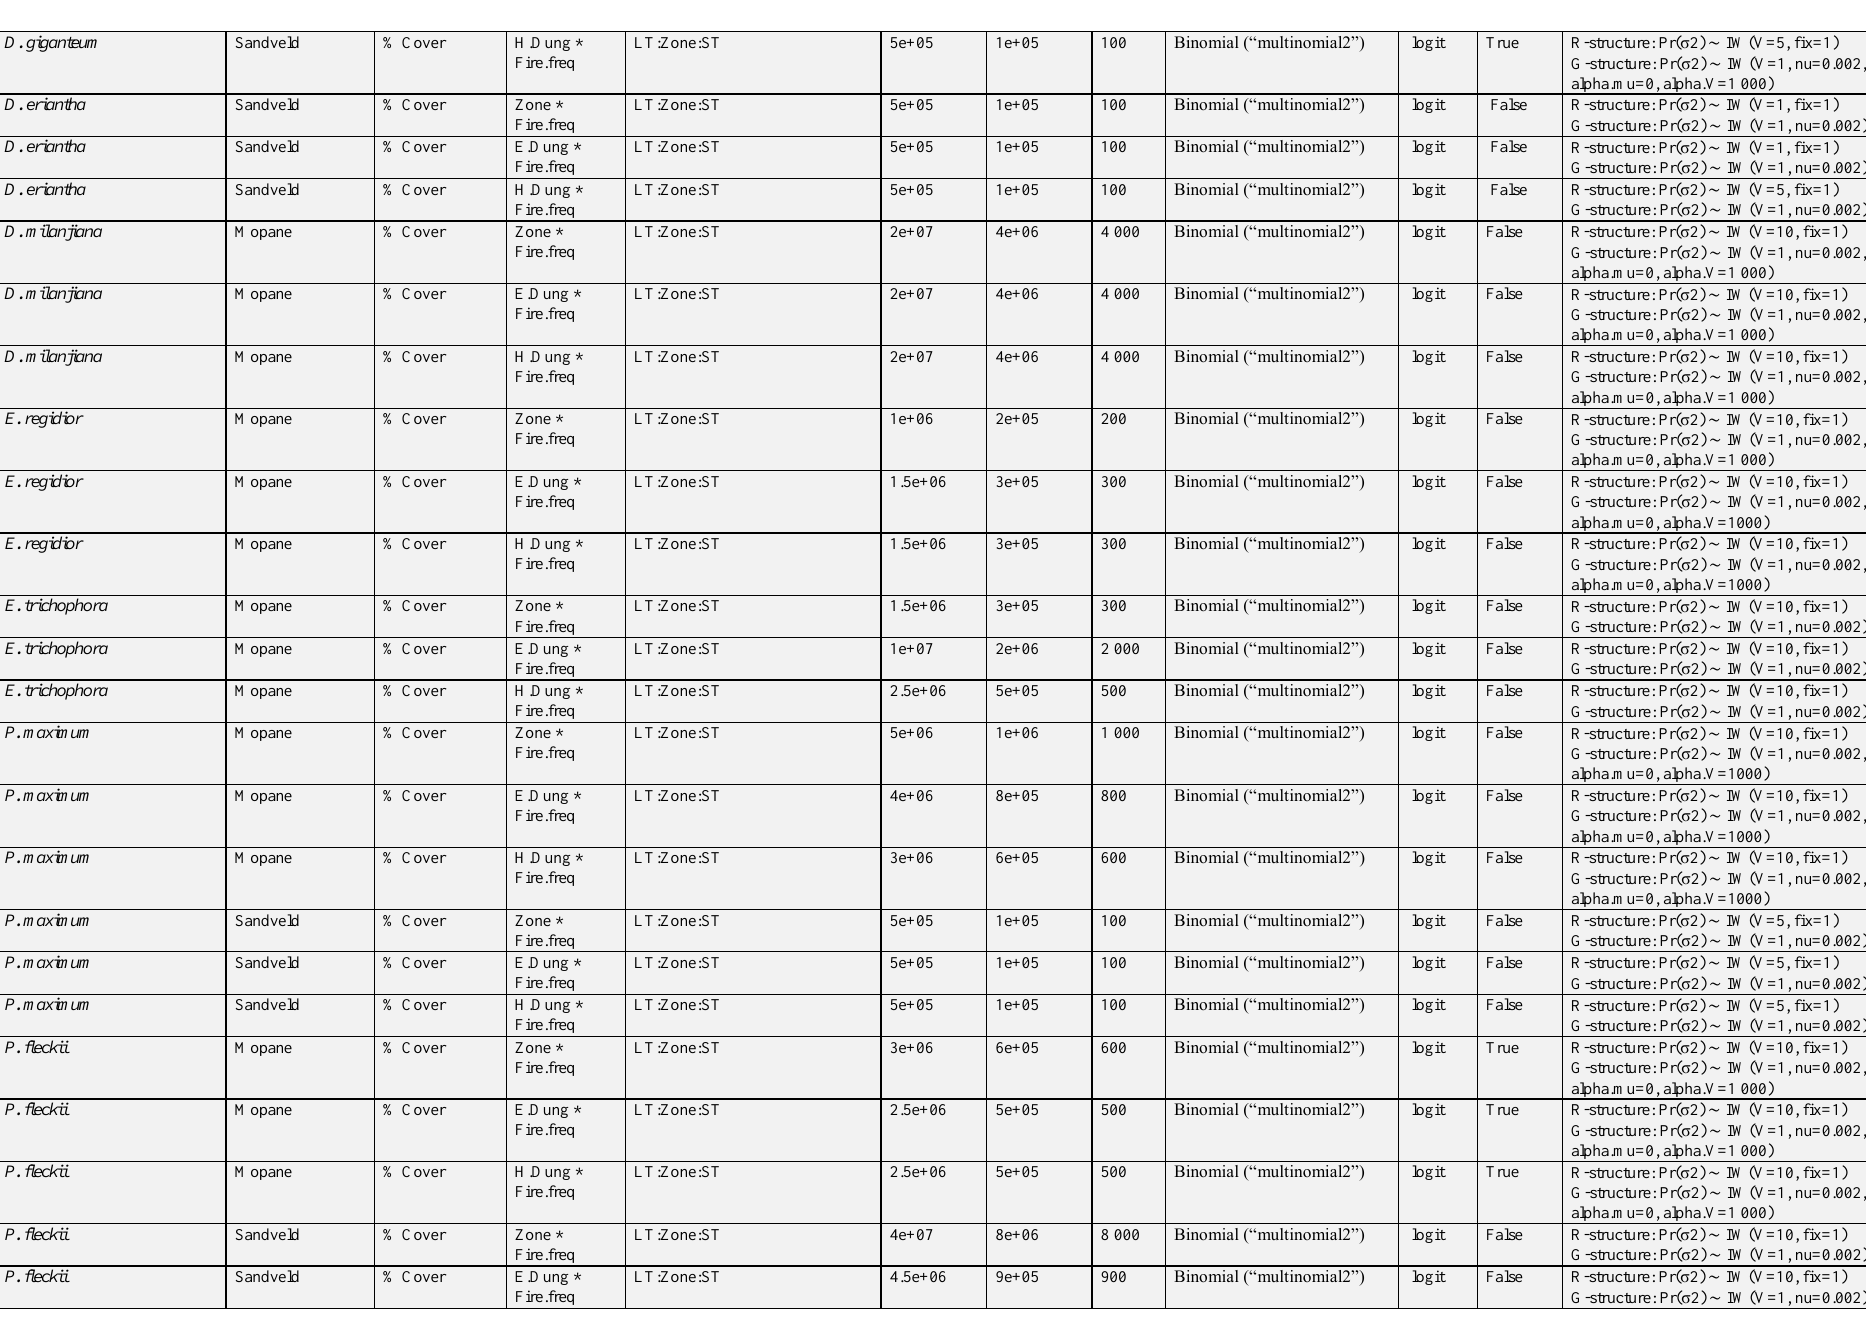
Binomial (“multinomial2”) logit False R-structure: Pr(σ2) ∼ IW(V=5, fix=1) G-structure: Pr(σ2) ∼ IW(V=1,